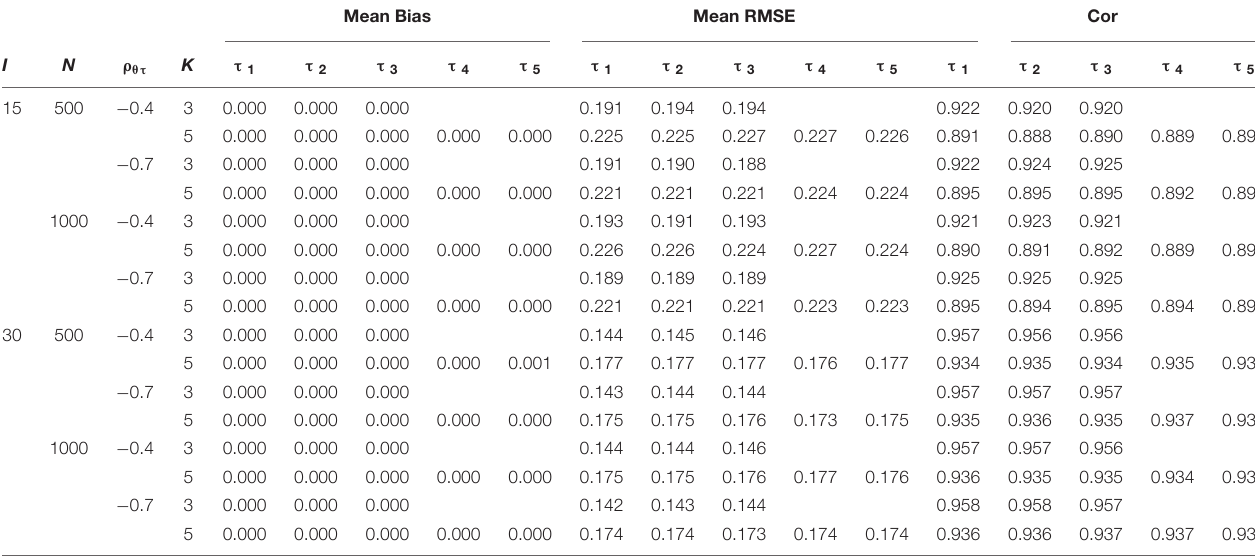
TABLE 6 | Recovery of multifactor speed in simulation study 1.